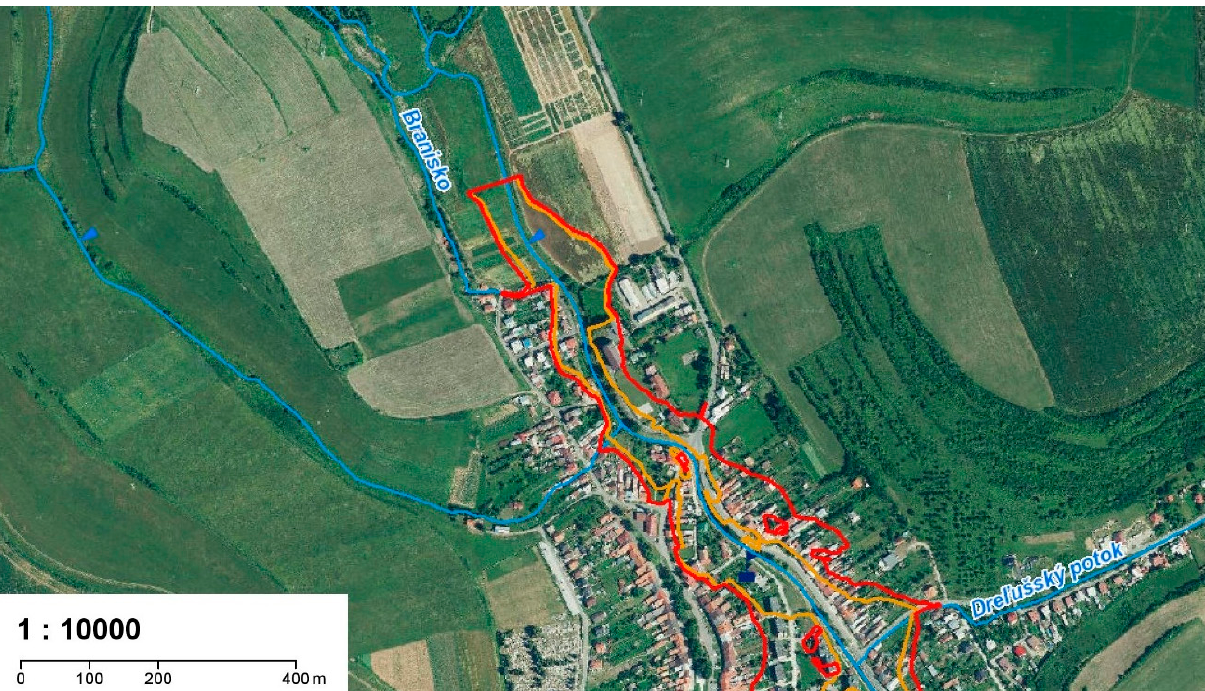
Figure 3. Geolocation of the studied area: flood levels for Q100 (red-colored line); Q50 (yellow-colored line); the river system represents Branisko stream (blue-colored line). Source: Slovak Hydrometeorological Institute.